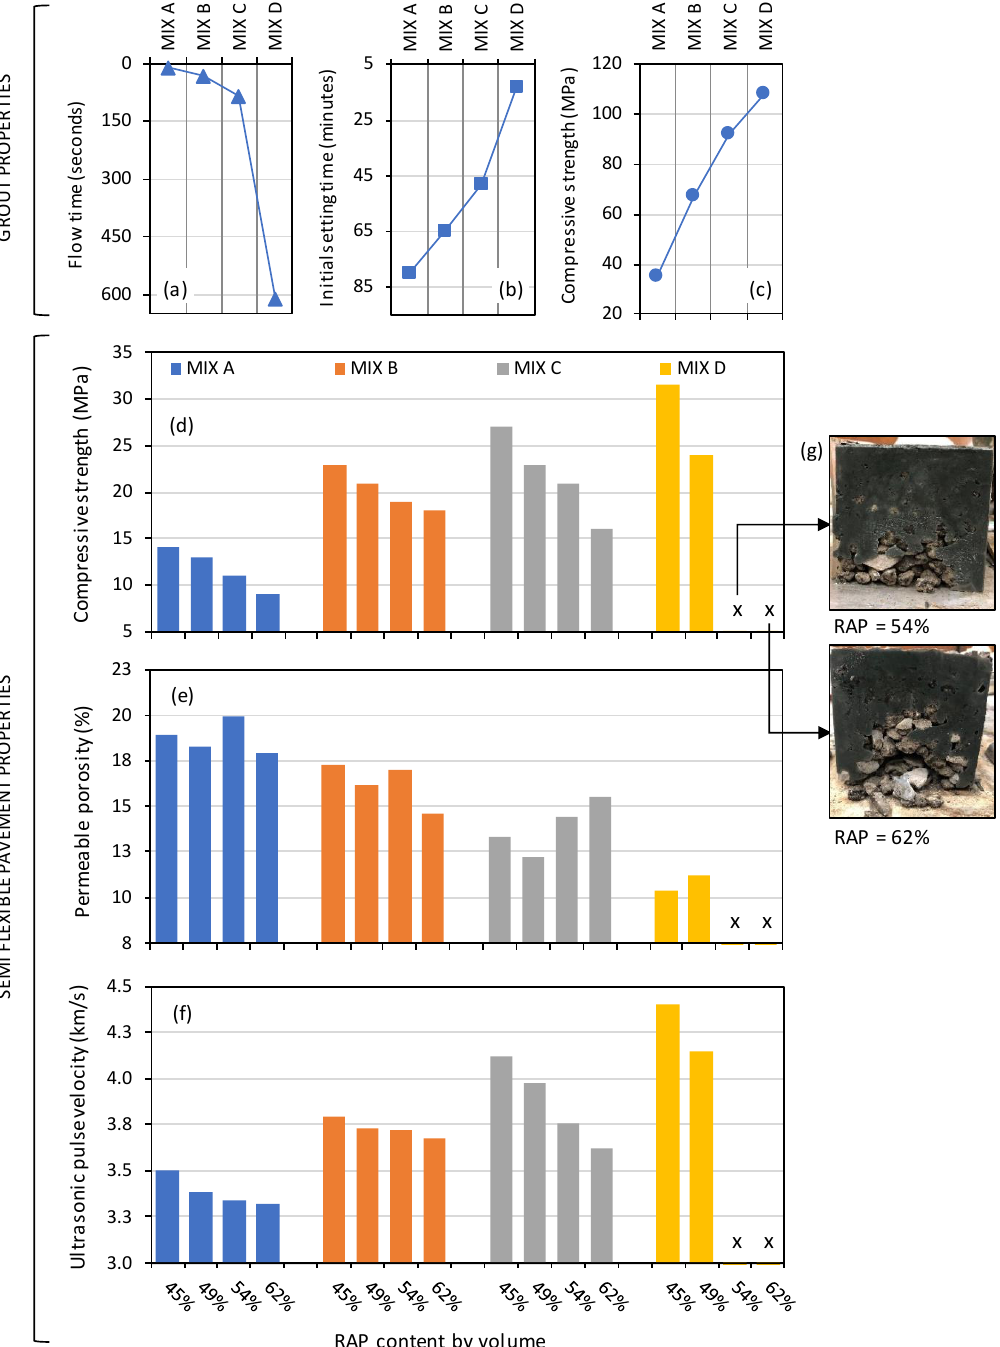
Figure 4. ( a – c ) Performance summary for grout Mix A, B, C, and D; SFC performance in terms of: ( d ) 28-day compressive strength; ( e ) permeable porosity; and ( f ) ultrasonic pulse velocity; and ( g ) images showing failure of selected specimens owing to insufficient grout penetration.